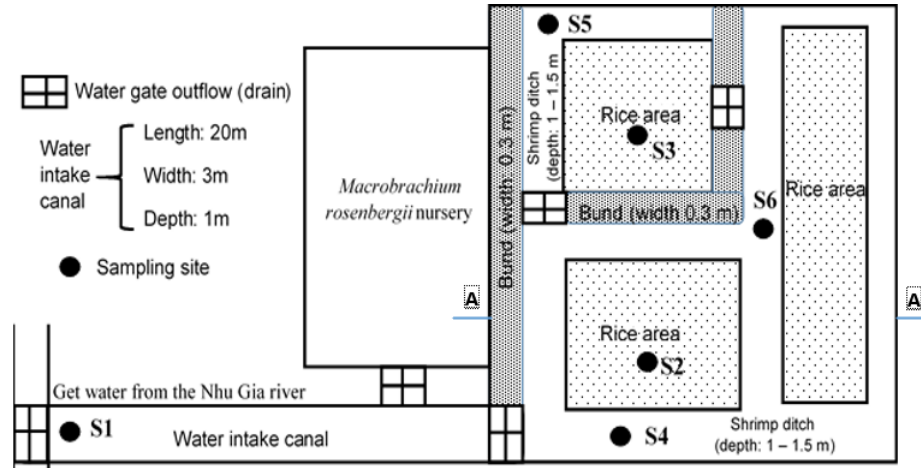
Figure 1. Overview of the water sampling locations.